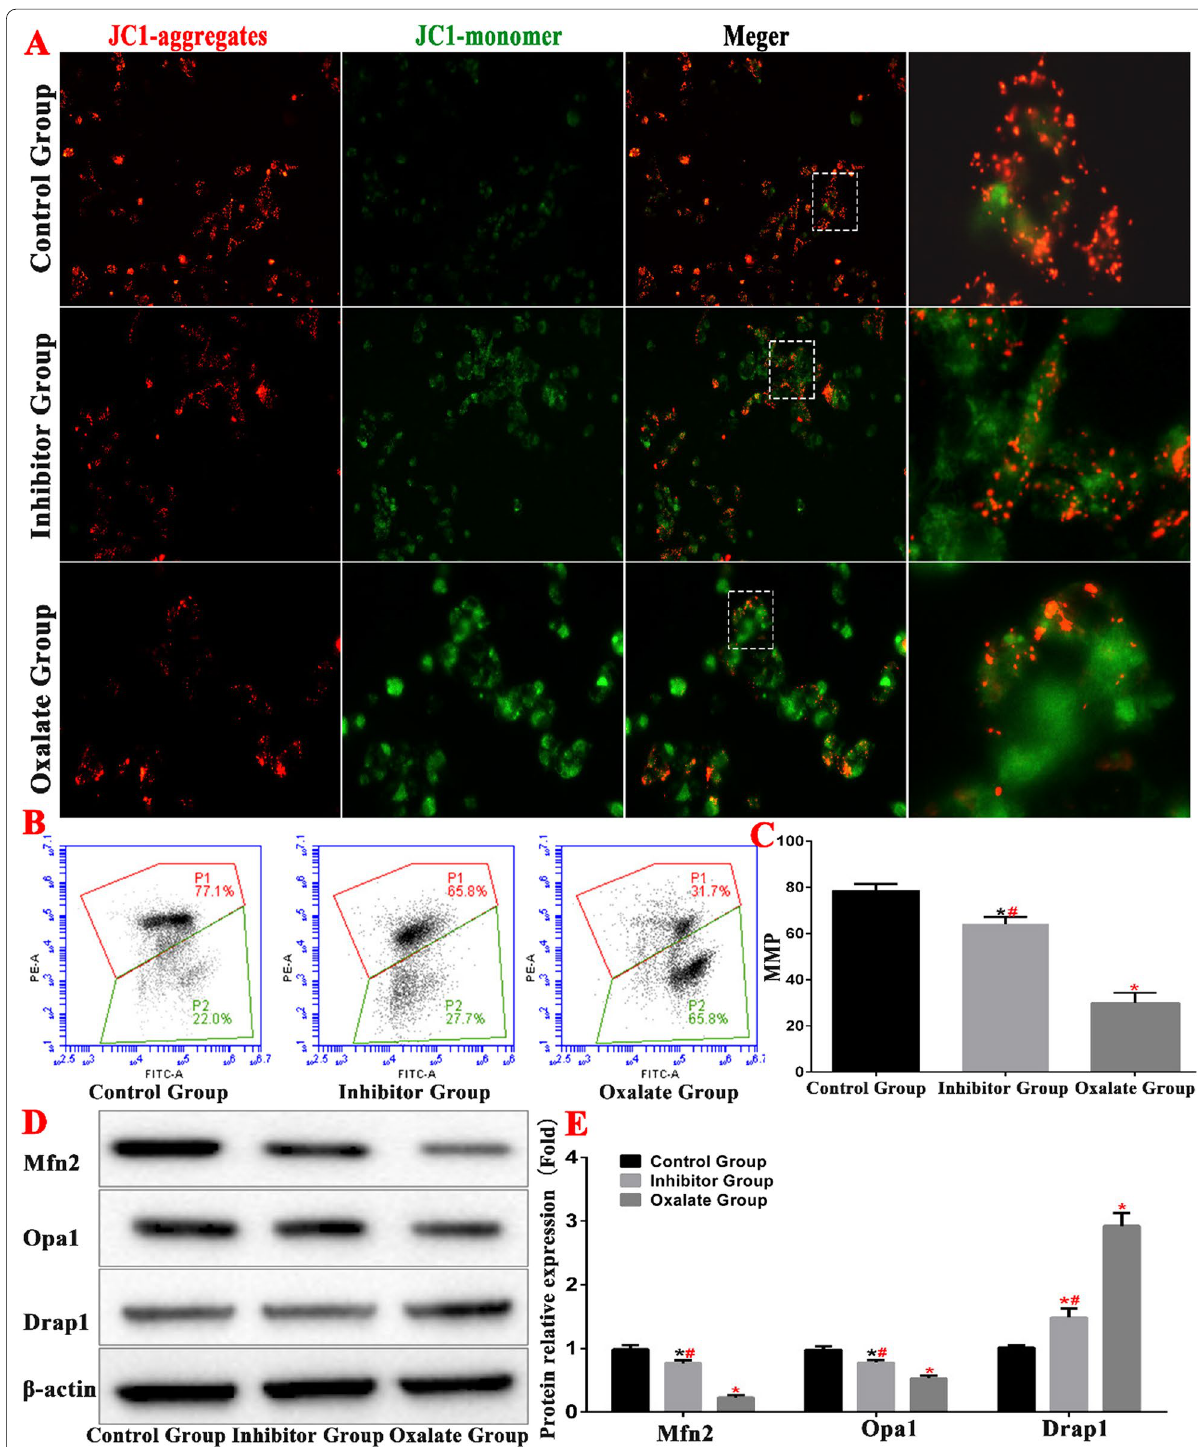
Fig. 5 Oxalate-induced mitochondrial damage in HK-2 cells. A MMP detection in JC-I fluorescence groups. B , C Comparison of MMP detection in each group by flow cytometry. D , E Western blot was used to detect the expression of mitochondrial related protein in each group (*compared with normal control group, P < 0.05.* (Red) Compared with control group, P < 0.01. #(Red) Compared with oxalate group, P <